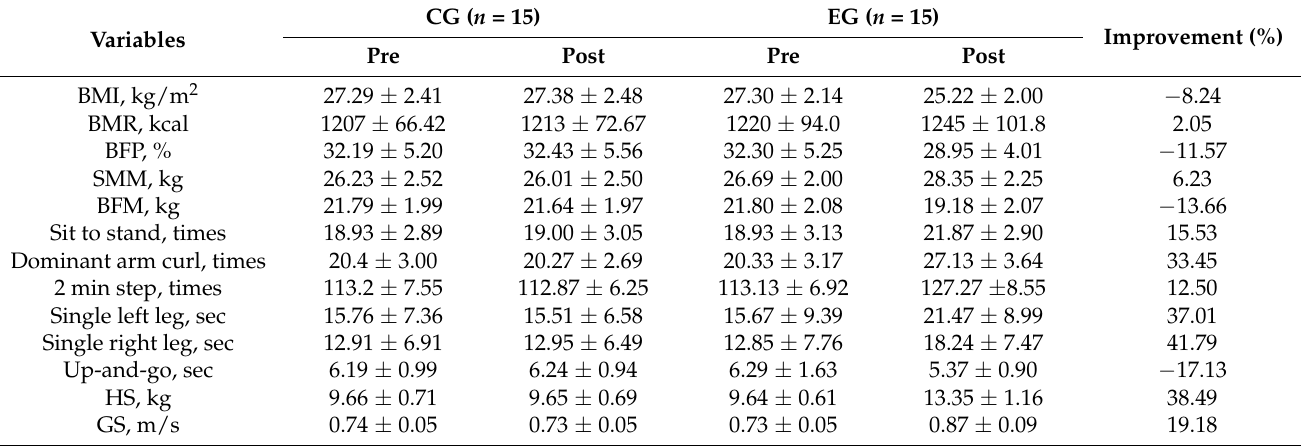
Table 4. Body composition, SFT test, and sarcopenia scores of the EG and CG for the pre- and post-tests.